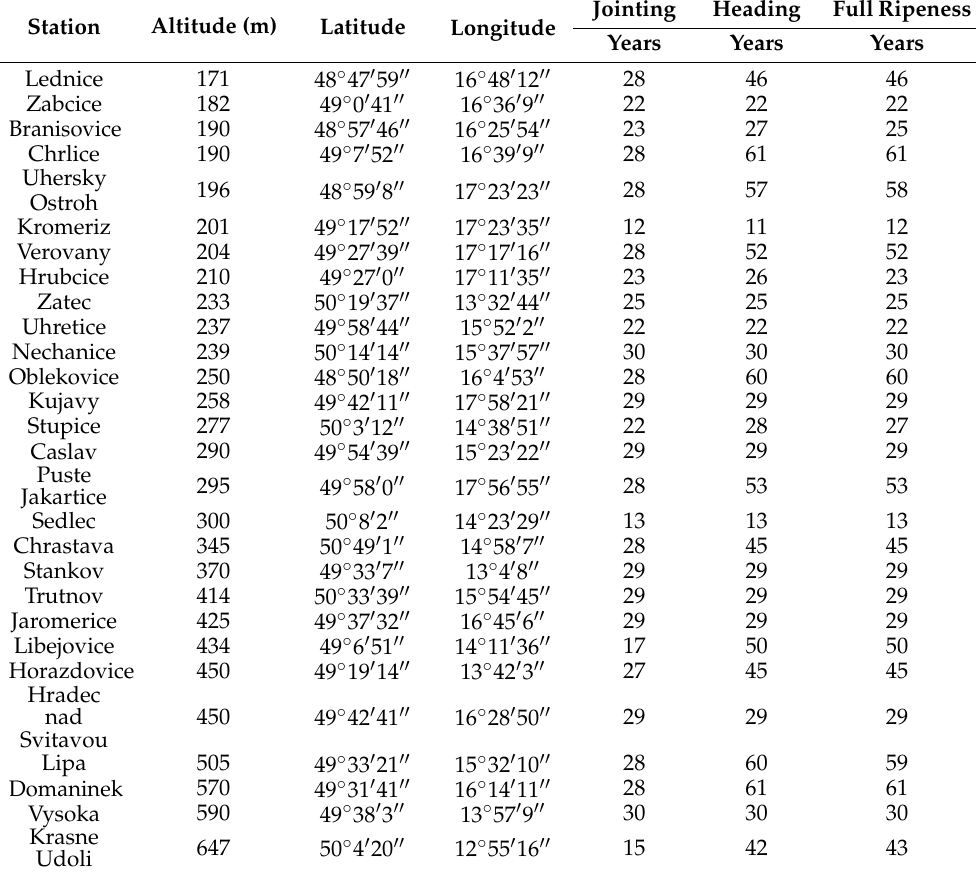
Puste Jakartice